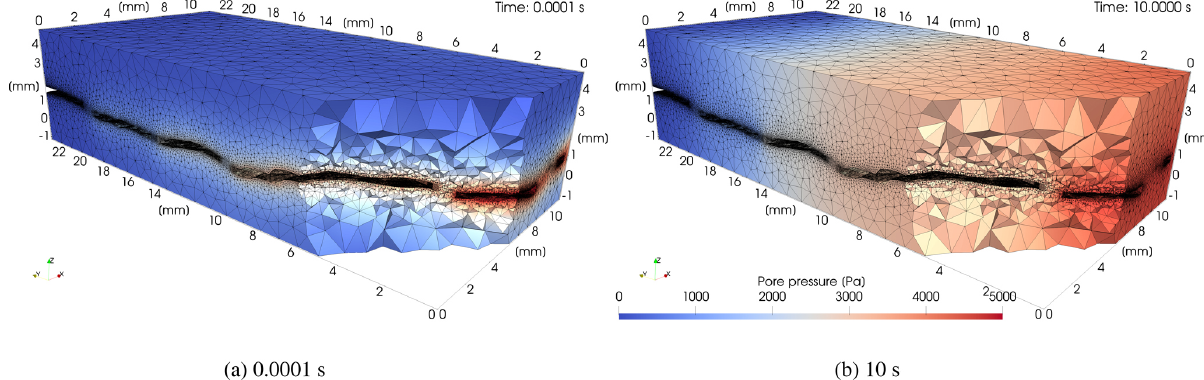
Figure 5. Pressure field in the matrix-fracture system after 0.0001 (a) and 10s (b) of inflow, respectively.